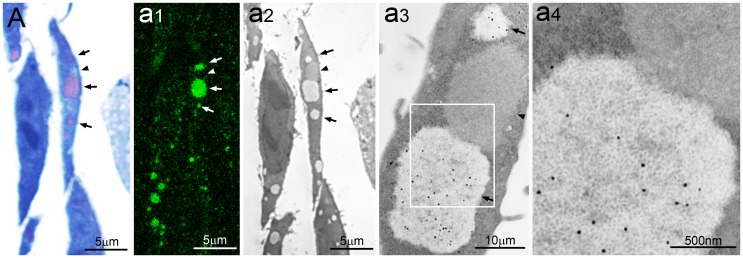
PaCSs are metachromatic and chondroitin sulfate-positive bodies.(A) Toluidine blue metachromatic bodies (arrows) corresponding to chondroitin sulfate immunofluorescent bodies (a1), and TEM-characterized PaCSs (a2–4) in consecutive aldehyde–osmium-fixed resin sections of HeLa cells. A sequestosome (arrowhead) lightly stained (A), unreactive for chondroitin sulfate (a1) and moderately electron dense (a2) is enlarged in (a3) and (a4) to show its distinctive ultrastructure and unreactivity for FK1 immunogold, which selectively labeled the adjacent particle-filled PaCS.